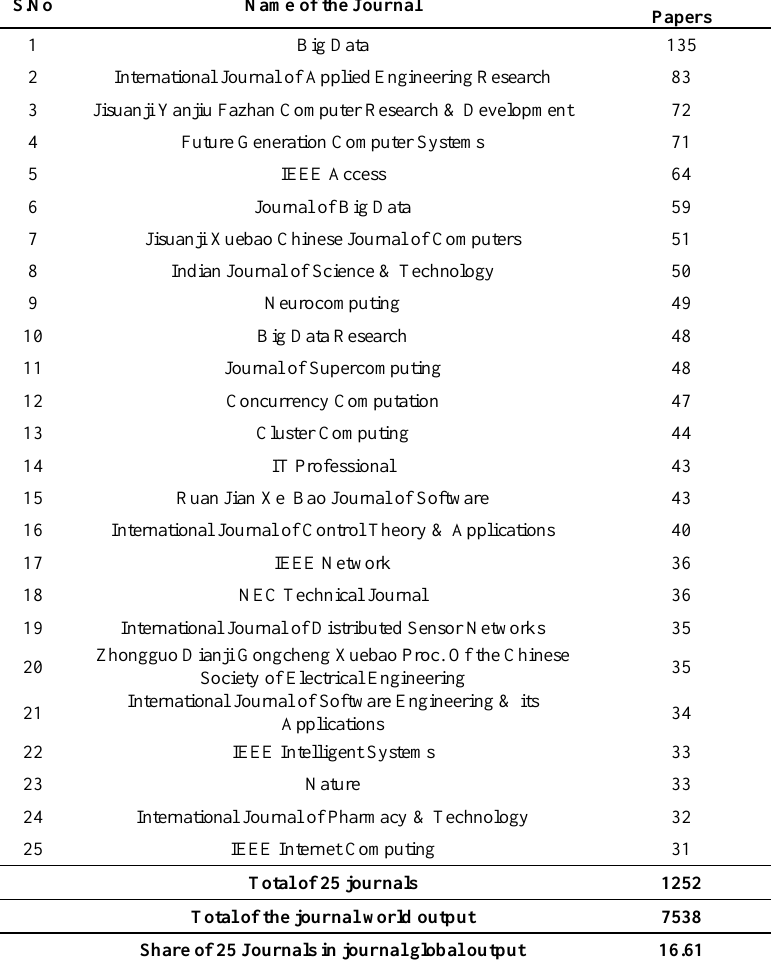
Table 11. Top 25 Most Productive Journals in Global Big Data Research during